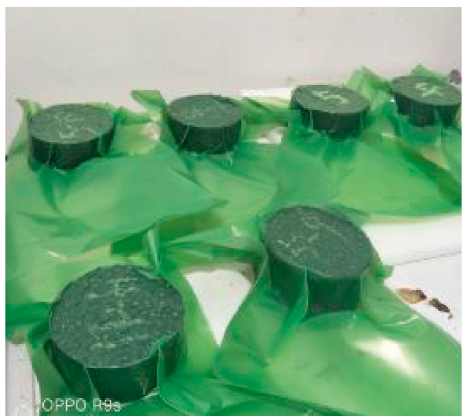
Figure 6: Sealed specimens.